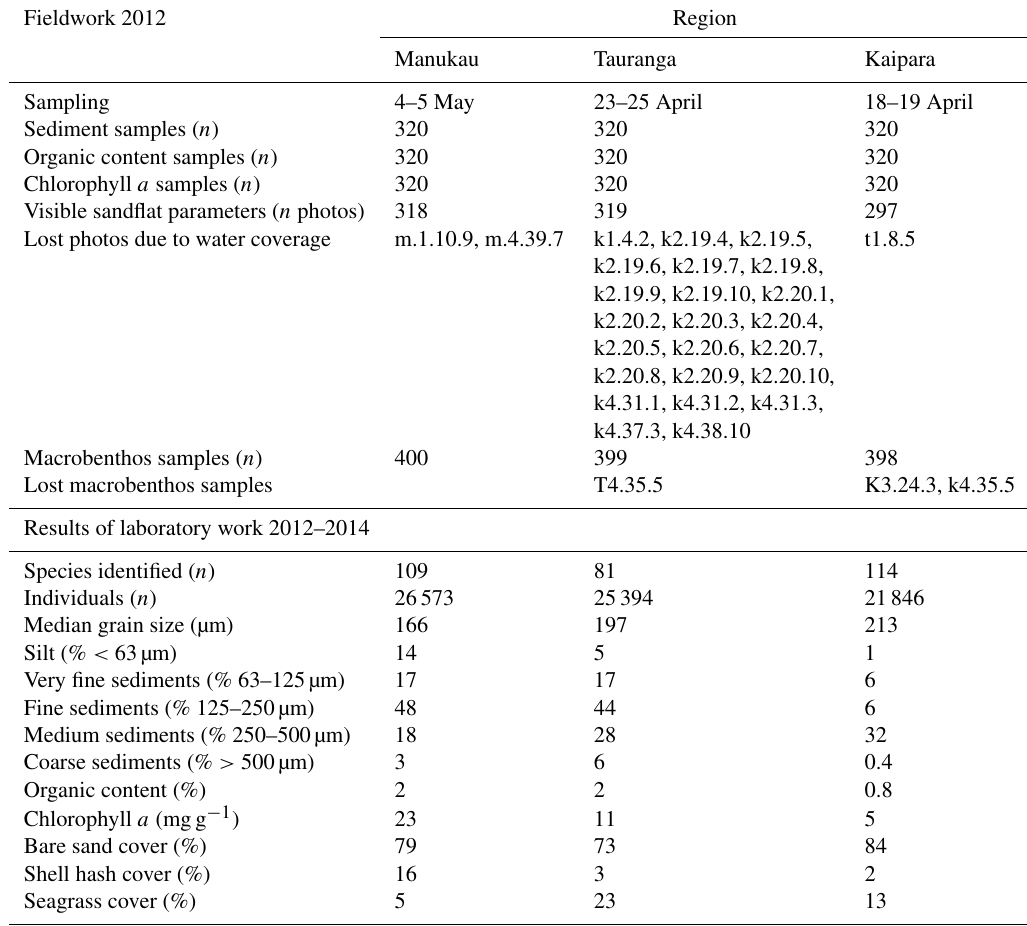
Table 1. Regional summary of collected data and their mean values to give an impression of their physical appearance and the macrobenthic benthic biodiversity they